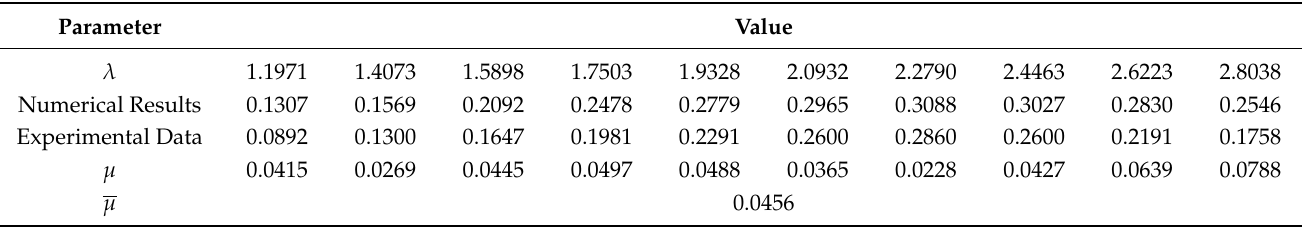
Figure 7. Comparison between numerical and experimental results. ( a ) Averaged power coefficients. ( b ) Torque coefficients. Table 3. Comparison of errors between numerical and experimental